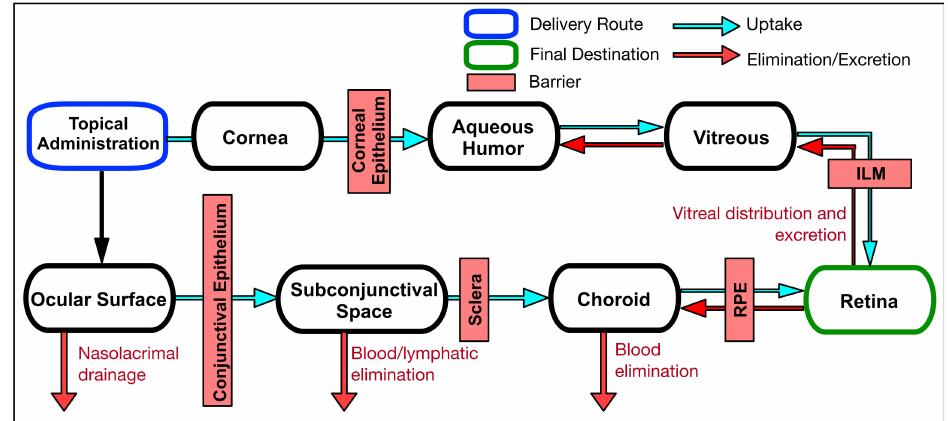
Figure 5. Drug pathway after topical administration. Topical delivery requires the drug to pass through multiple chambers before reaching the retina. This is in conjunction with rapid nasolacrimal drainage from the first compartment which contributes to the poor retinal bioavailability resulting from topical